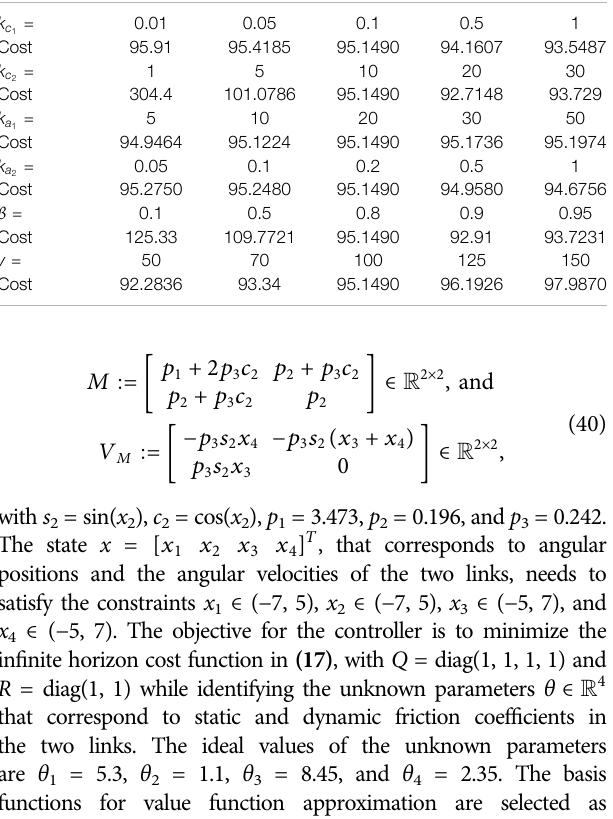
TABLE 4 | Sensitivity Analysis for the four state system.